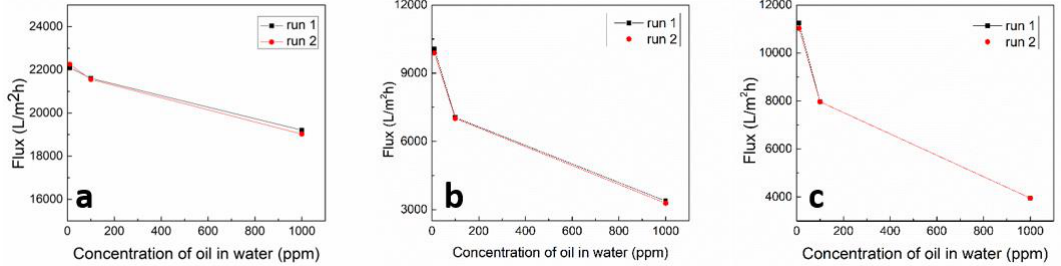
Figure 9. Flux of emulsions through the membranes of the ( a ) neat coPA, ( b ) coPA/ML-Ti 3 C 2 T x , and ( c ) coPA SL-Ti 3 C 2 T x at a constant pressure of 0.5 bar.